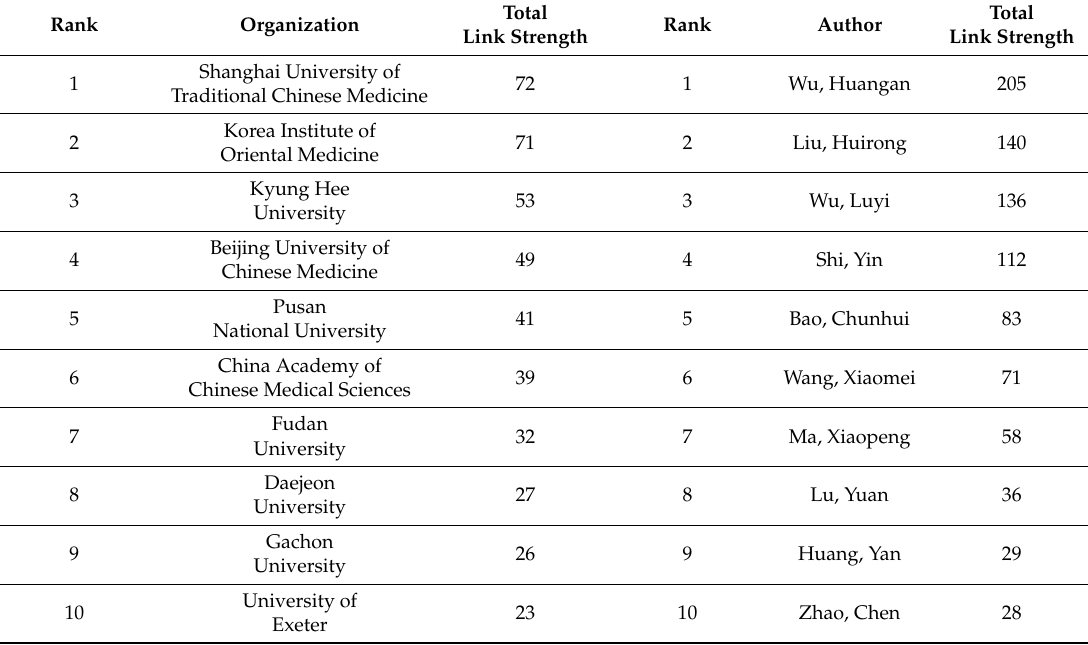
Table 5. The top 10 total link strengths of organizations and